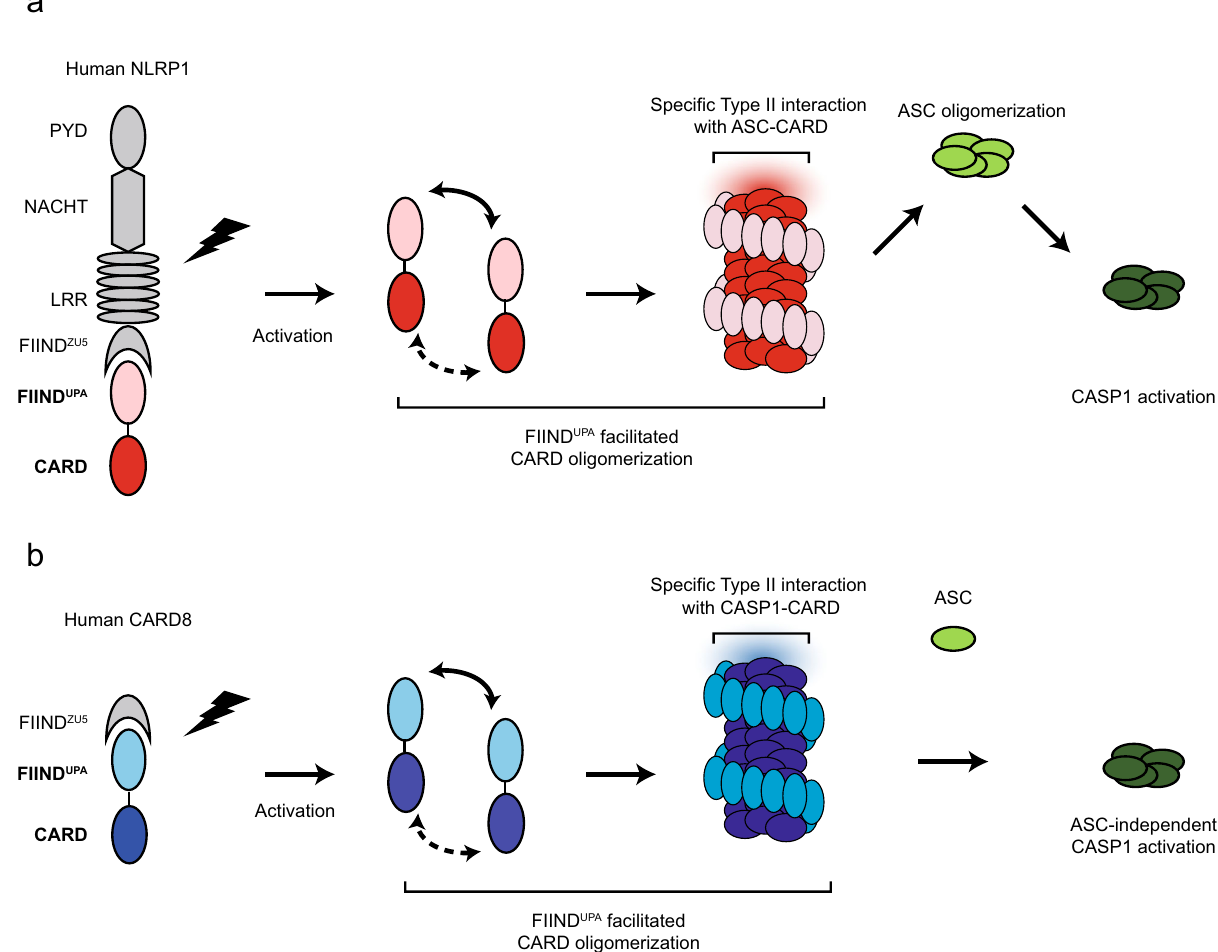
Fig. 7 A two-step model for human NLRP1 and CARD8 in fl ammasome assembly. From left to right, NLRP1 ( a ) and CARD8 ( b ) are “ licensed ” by auto- proteolysis within the FIIND. Upon activation by PAMP or DAMP triggers, the self-inhibition exerted by the N-terminal proteolytic fragment is relieved. FIIND UPA facilitates the oligomerization of CARD, leading to the formation of a two-layered fi lament complex. Oligomerized NLRP1-CARD and CARD8- CARD differentially engage ASC or CASP1, leading to the assembly of distinct in fl ammasome